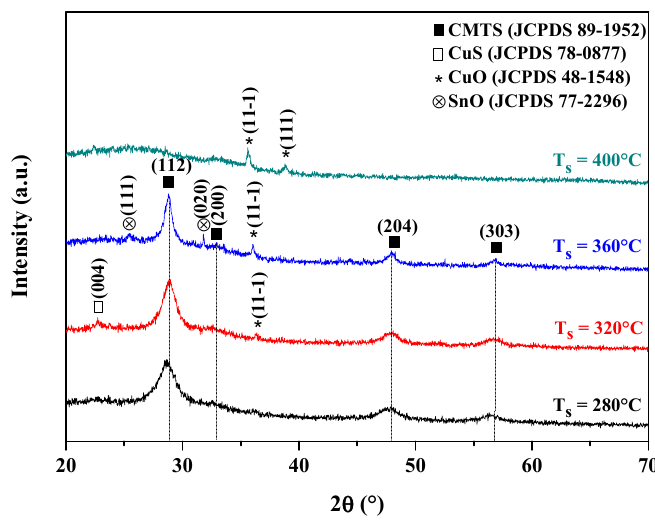
Figure 1. X-ray diffractograms of CMTS thin films grown at different substrate temperatures. Figure 1. X-ray di ff ractograms of CMTS thin films grown at di ff erent substrate